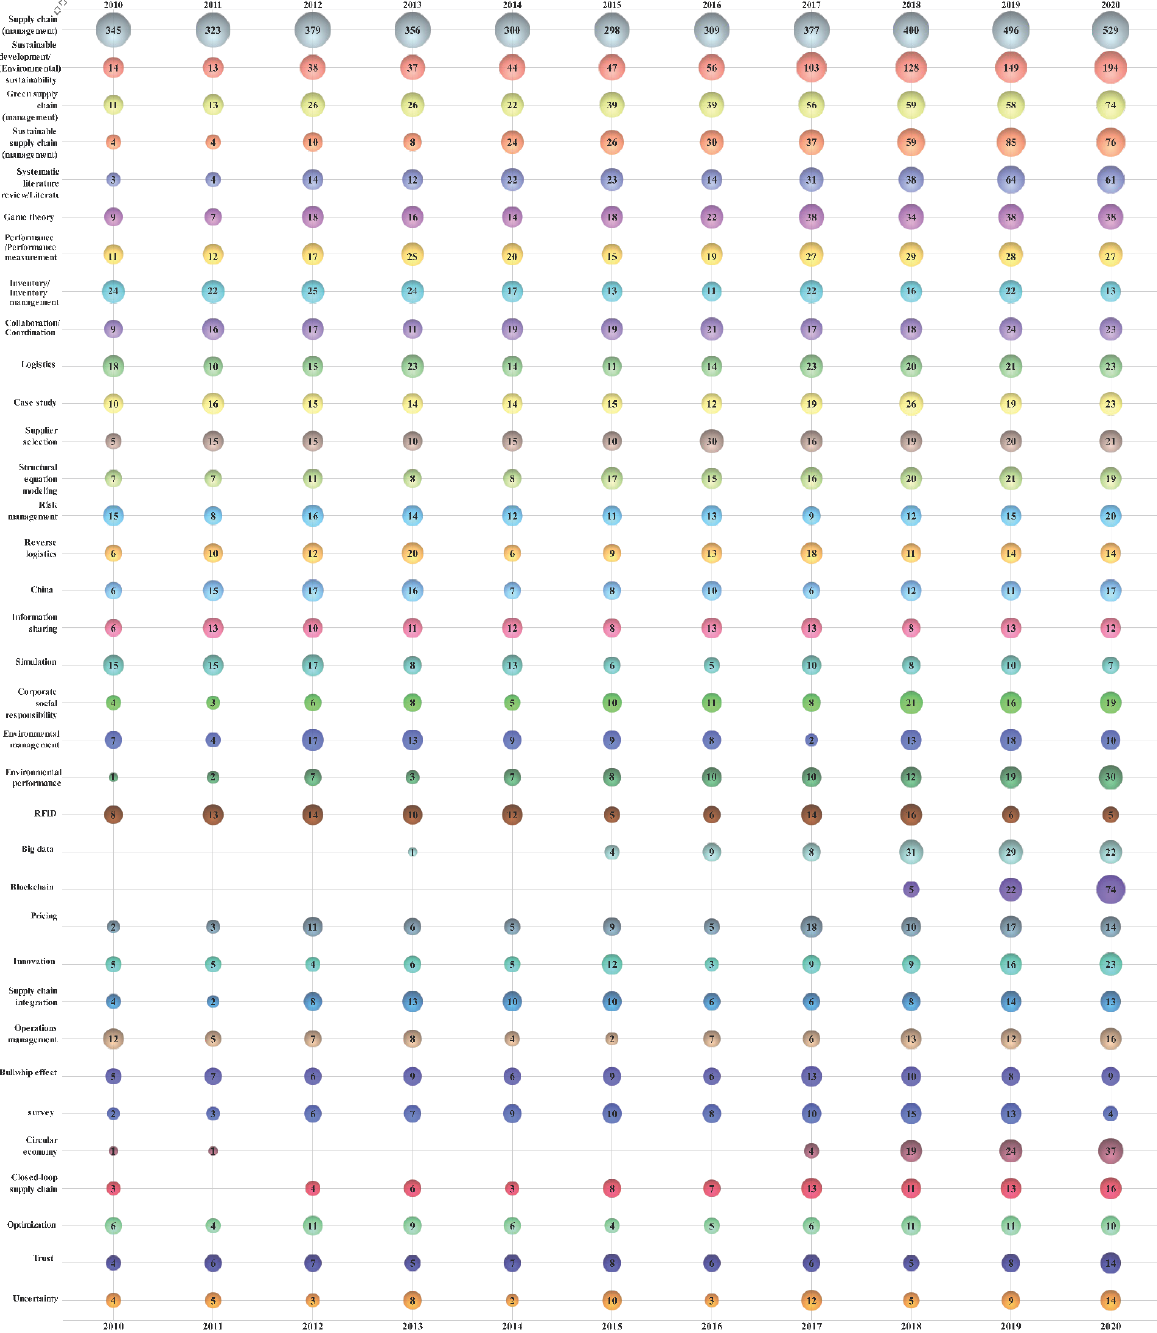
Figure 8. Bubble chart of top 35 author keywords by year.